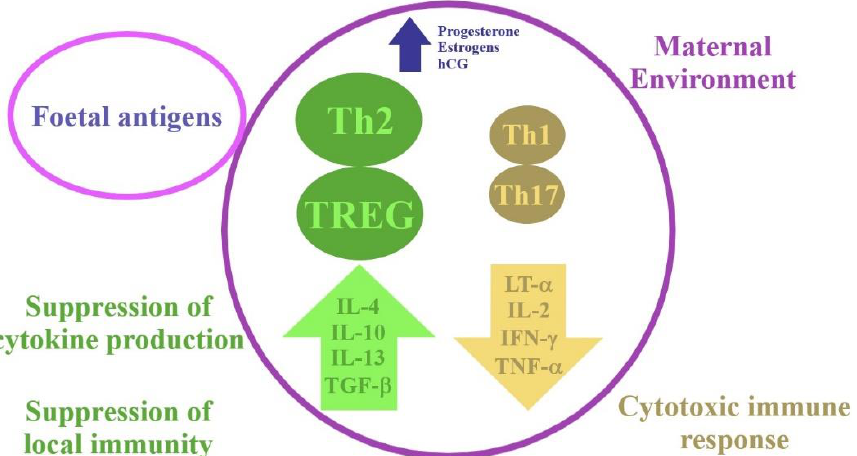
Figure 1. Physiological changes in the immune system in early pregnancy. hCG-human chorionic gonadotropin; IFN- γ -interferon gamma; IL-2-interleukin 2; IL-4-interleukin 4; IL-10-interleukin 10; IL-13-interleukin 13; LT- α -lymphotoxin-alpha; TGF- β -transforming growth factor beta; Th1-type 1 T helper cells; Th2-type 2 T helper cells; Th17-T helper 17 cells; TNF- α -tumour necrosis factor; TREG-regulatory T cell.